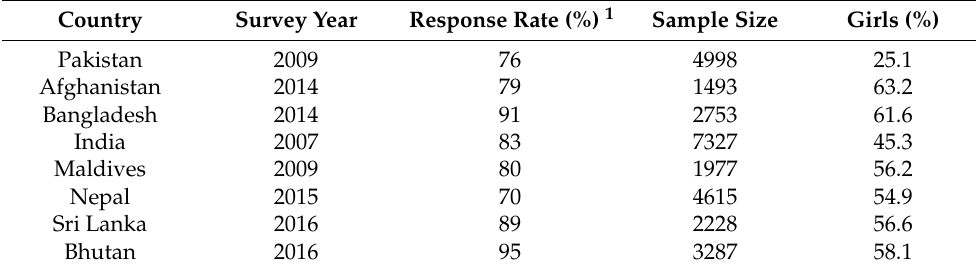
Table 1. Descriptive characteristics of South Asian schooled adolescents aged 12–15 years of the Global School-based student Health Survey.